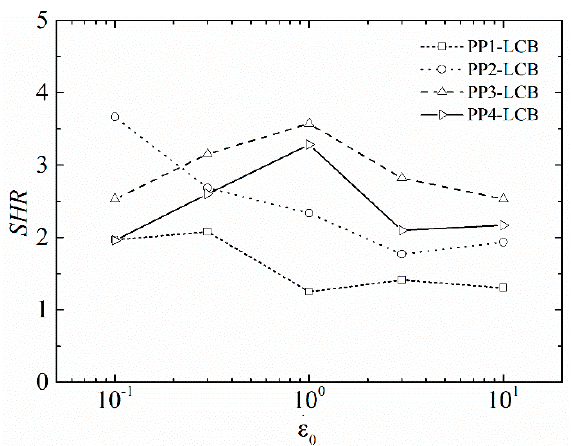
Figure 13. Strain hardening ratio of the LCB samples.